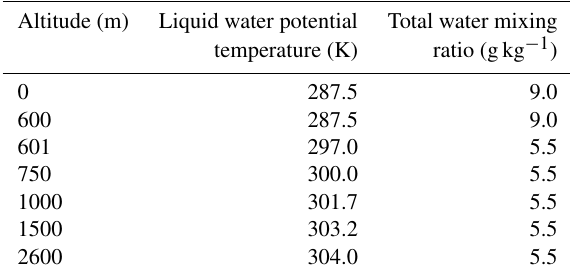
Table 1. Initial profiles used in the control simulations. Altitude (m) Liquid water